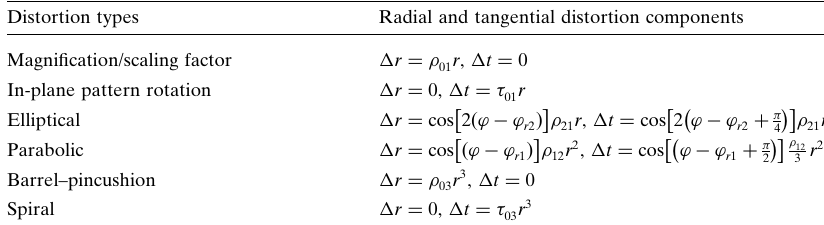
Figure 1 Different types of distortion in electron diffraction patterns: ( a ) original undistorted image, ( b ) elliptical distortion with the distortion axis inclined 30 (cid:3) away from the vertical axis, ( c ) parabolic (coma) distortion, ( d ) barrel with a negative (cid:3) distortion. Table 1 Different types of distortions observed in 2D electron diffraction patterns – formulae for the radial and tangential